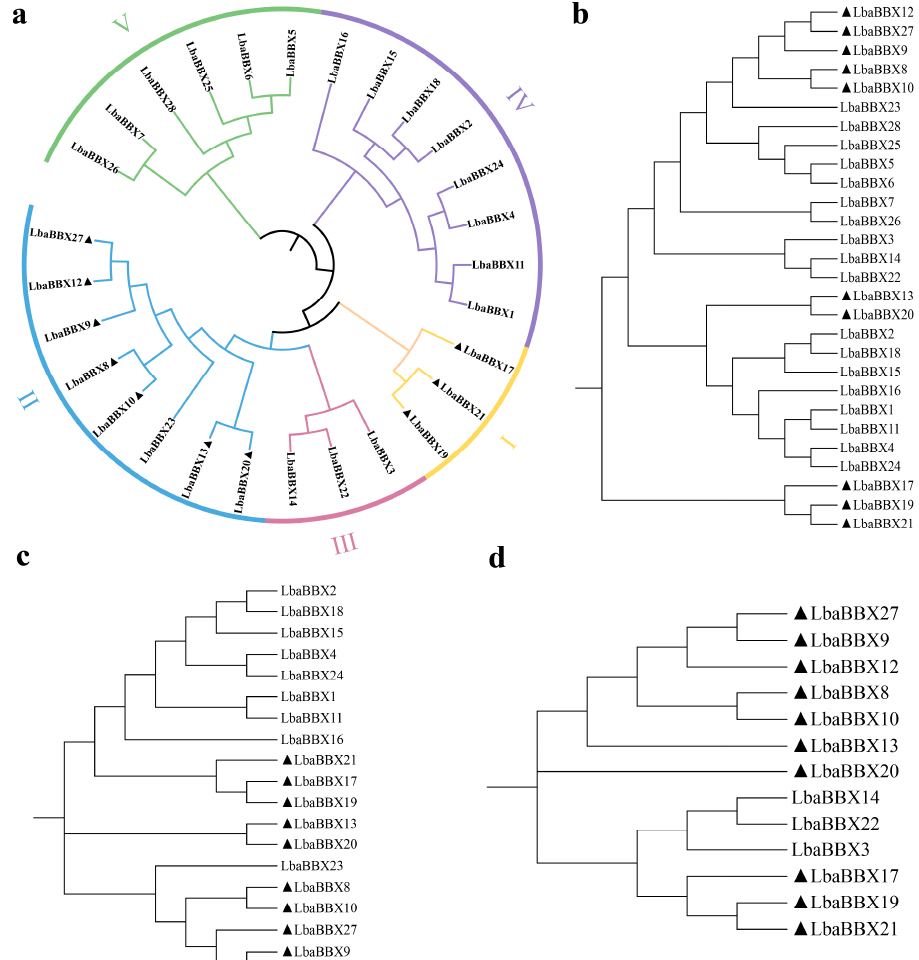
Figure 1. Phylogenetic tree analysis of BBX proteins in wolfberry. ( a ) The trees shown were based on the alignments of the protein sequences of the full length, and the phylogenetic tree was constructed using maximum likelihood method with 1000 bootstrap replicates by IQ-TREE. ( b – d ) The tree shown were based on the alignments of the protein’s sequences of the B-box 1 domain, B-box 2 domain and CCT domain, respectively. The members marked in black triangle contain two B-Box and one CCT domains.